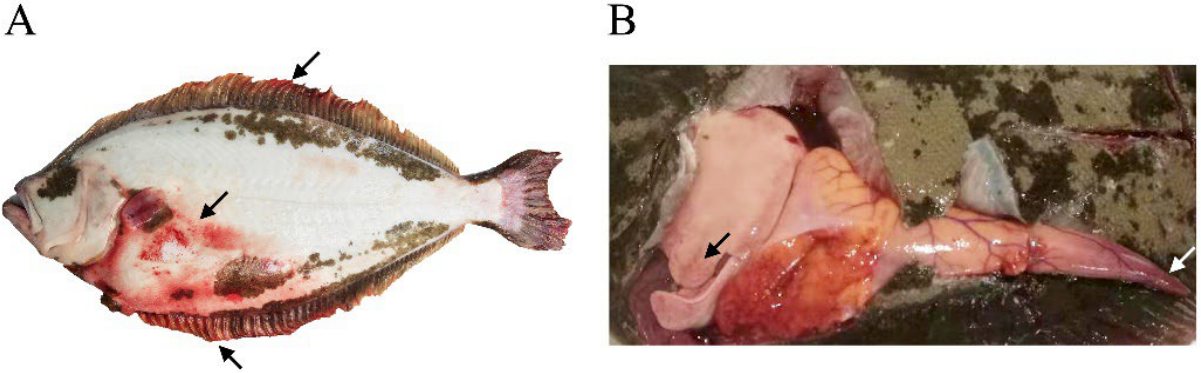
Figure 1. Clinical signs of CSBV Bces-Po19 infected Japanese flounder ( Paralichthys olivaceus ). The clinical signs observed in the moribund fish were partial body surface reddening, especially hem- orrhages in fins and abdominal muscles. ( A ) The blind side of fish with CSBV Bces-Po19 disease; ( B ) visceral organs of the abdomen. Arrows indicate the hemorrhage positions.